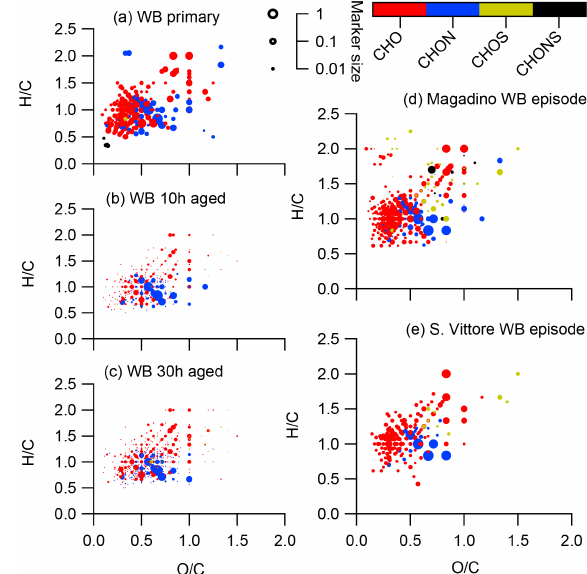
Figure 10. Van Krevelen diagrams of negative ion mode spectra (neutral composition) of smog chamber wood-burning experiments (fresh emissions, after 10h of simulated atmospheric aging, and after 30h of simulated atmospheric aging) and of wood-burning episodes at the Alpine valley sites Magadino and San Vittore. Peaks are displayed as circles with their size reflecting log(intensity) and the colour code reflecting the molecular composition of the com-